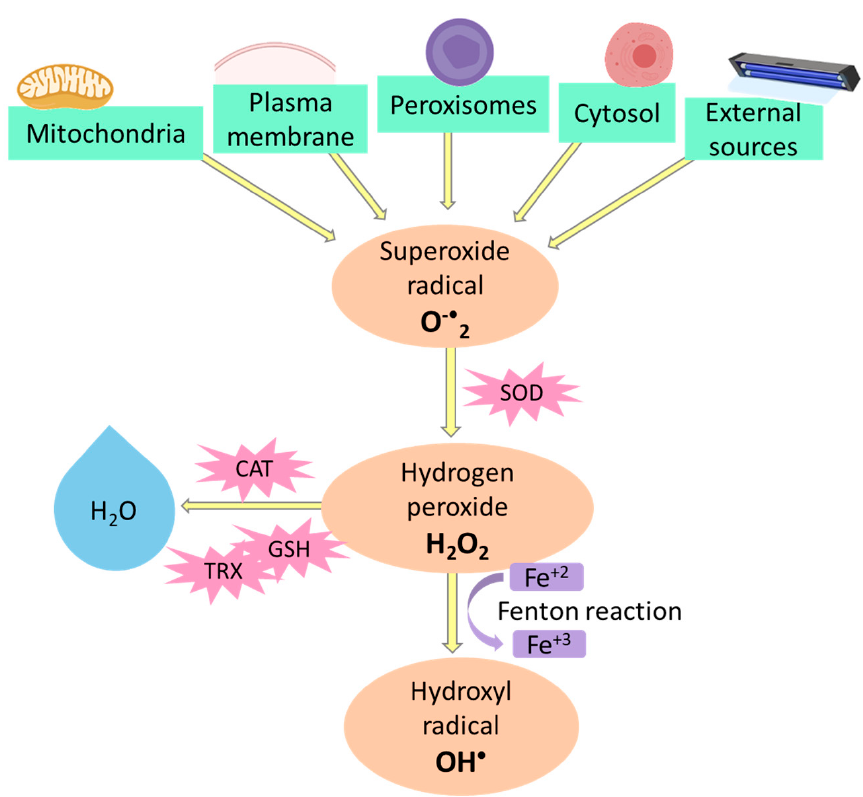
Figure 1. Generation of reactive oxygen species. The superoxide radical is generated by the mito- chondria, plasma membrane, peroxisomes, cytosol, and external sources such as U.V. light. Then, it receives an electron to transform into H 2 O 2 ; this reaction is catalyzed by the enzyme superoxide dismutase (S.O.D.). H 2 O 2 can be metabolized by catalases (C.A.T.), glutathione peroxidases